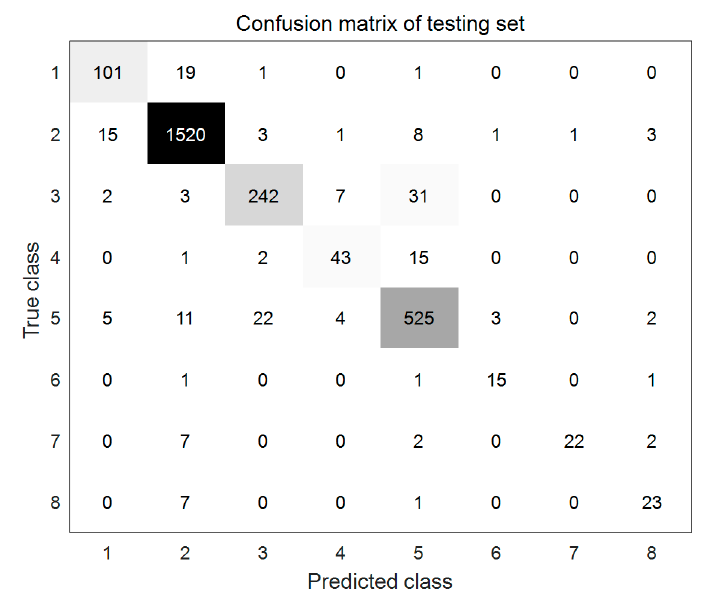
Figure 11. Confusion matrix of testing set.